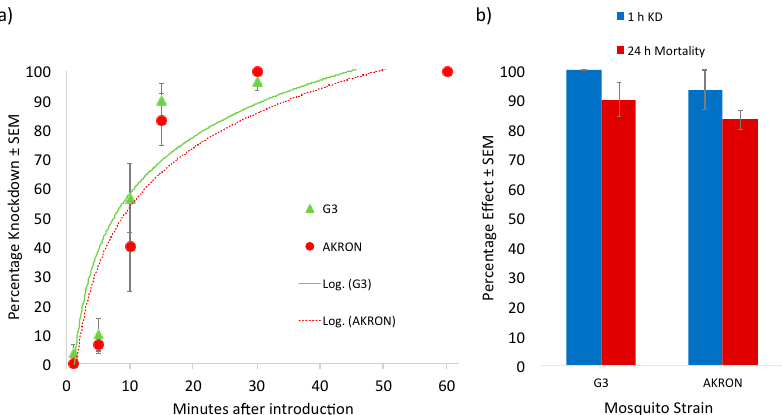
Figure 2. Knockdown response of Anopheles gambiae strains exposed to a discrete dose of permethrin. ( a ) AKRON strain experienced lower percentage knockdown than the G3 strain at all time points screened in this study. ( b ) Both strains experienced similar 1 h knockdown and 24 h mortality after removal from the exposure chamber.